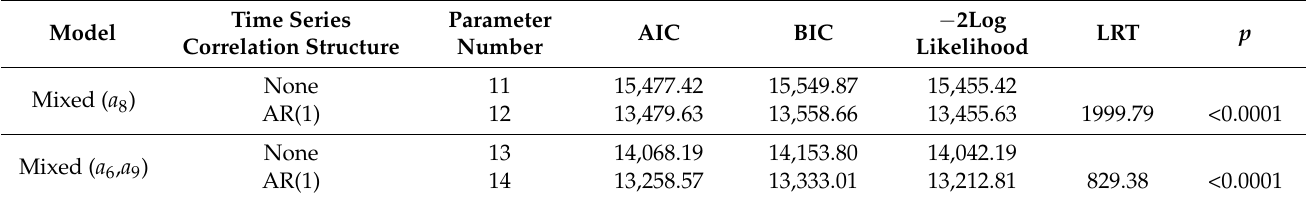
Table 10. Parameters, variance estimates and fitting statistics of different models.